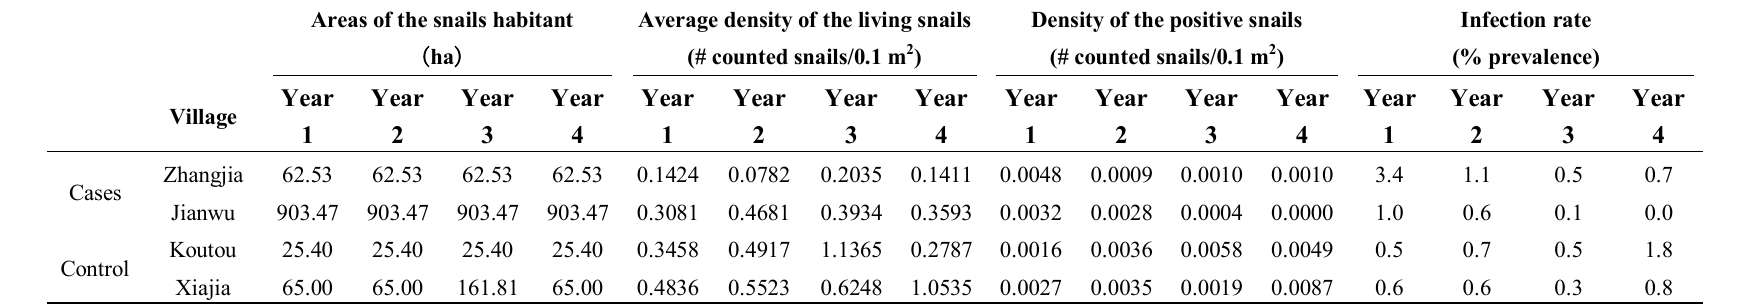
Table 4. The results of snail survey in four years.